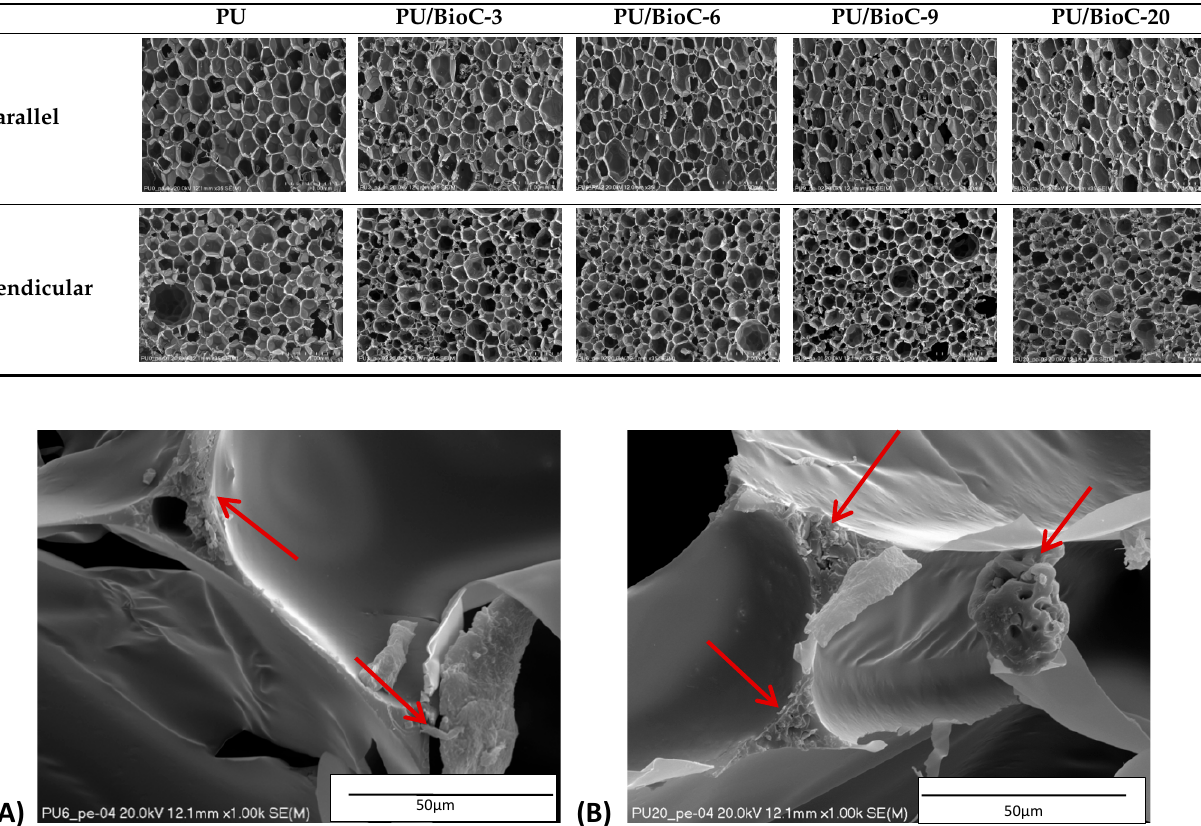
Table 2. Parameters of cellular structure and physical–mechanical properties of foams.